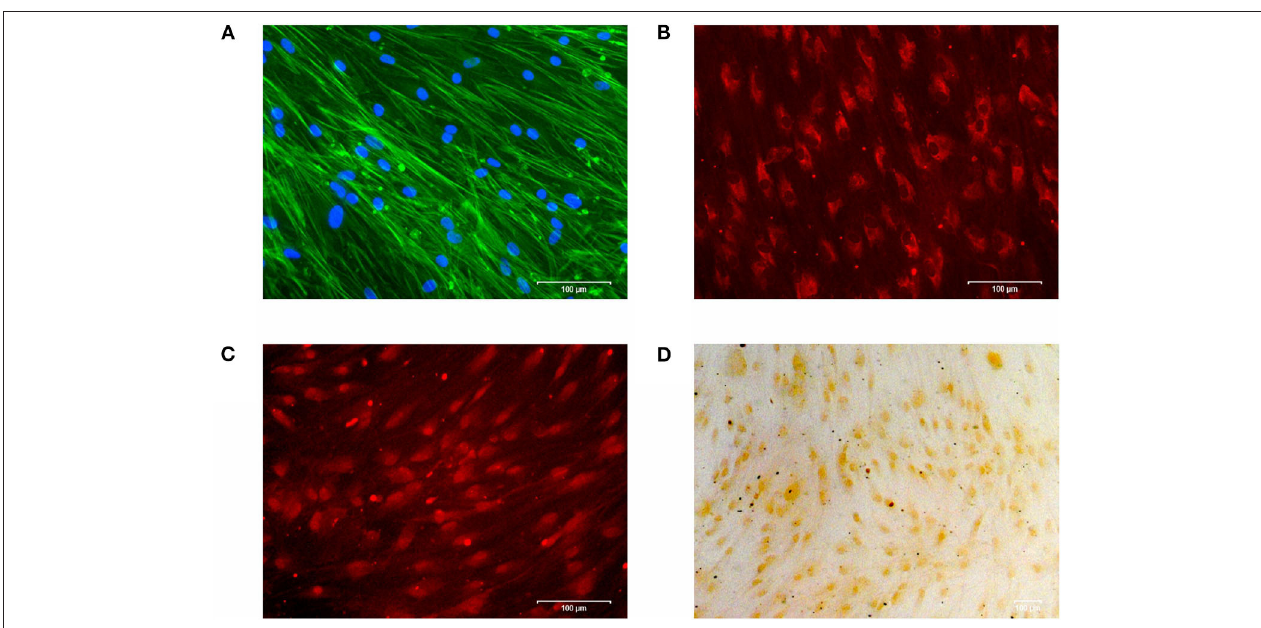
FIGURE 1 | (A) Cytoskeleton and cell viability of phAOBs were confirmed by DAPI/Phalloidin staining. (B) Expression of type I collagen visualized by immunofluorescence. (C) Immunofluorescence staining of osteocalcin. (D) Positive mineralization was confirmed by alizarin red staining. Scale bars indicate 100 µ m. Experiments were performed in triplicates and representative images of cells from one donor are shown.